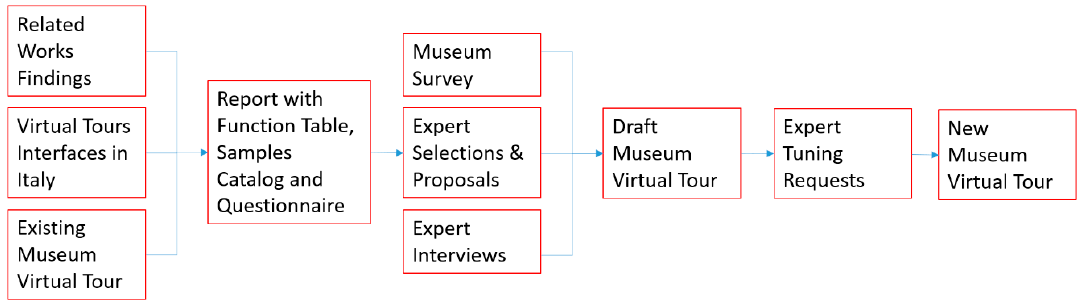
Figure 5. Production steps of the virtual tour of the archaeological Museum of Altamura (expert contribution phase).